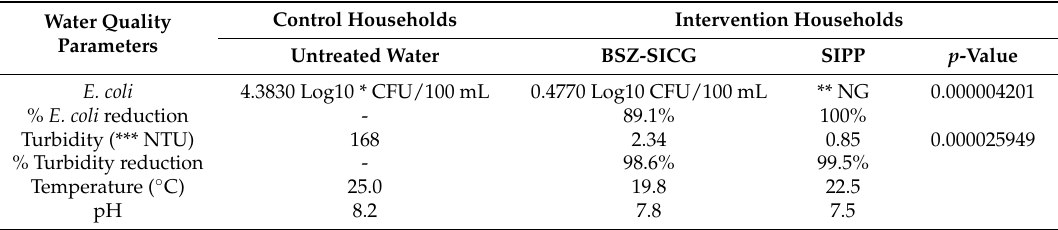
Table 3. Mean E. coli reduction, turbidity reduction, temperature, and pH of untreated and treated water from control and intervention